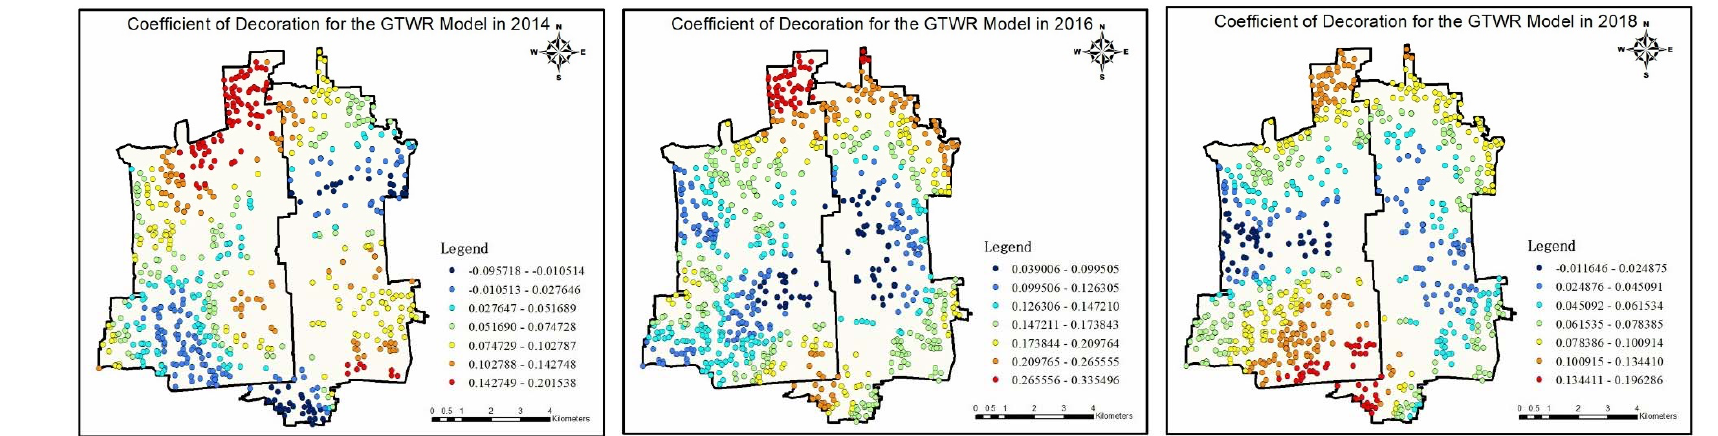
Figure 6. Coefficient of decoration for the GTWR model in 2014, 2016, and 2018.